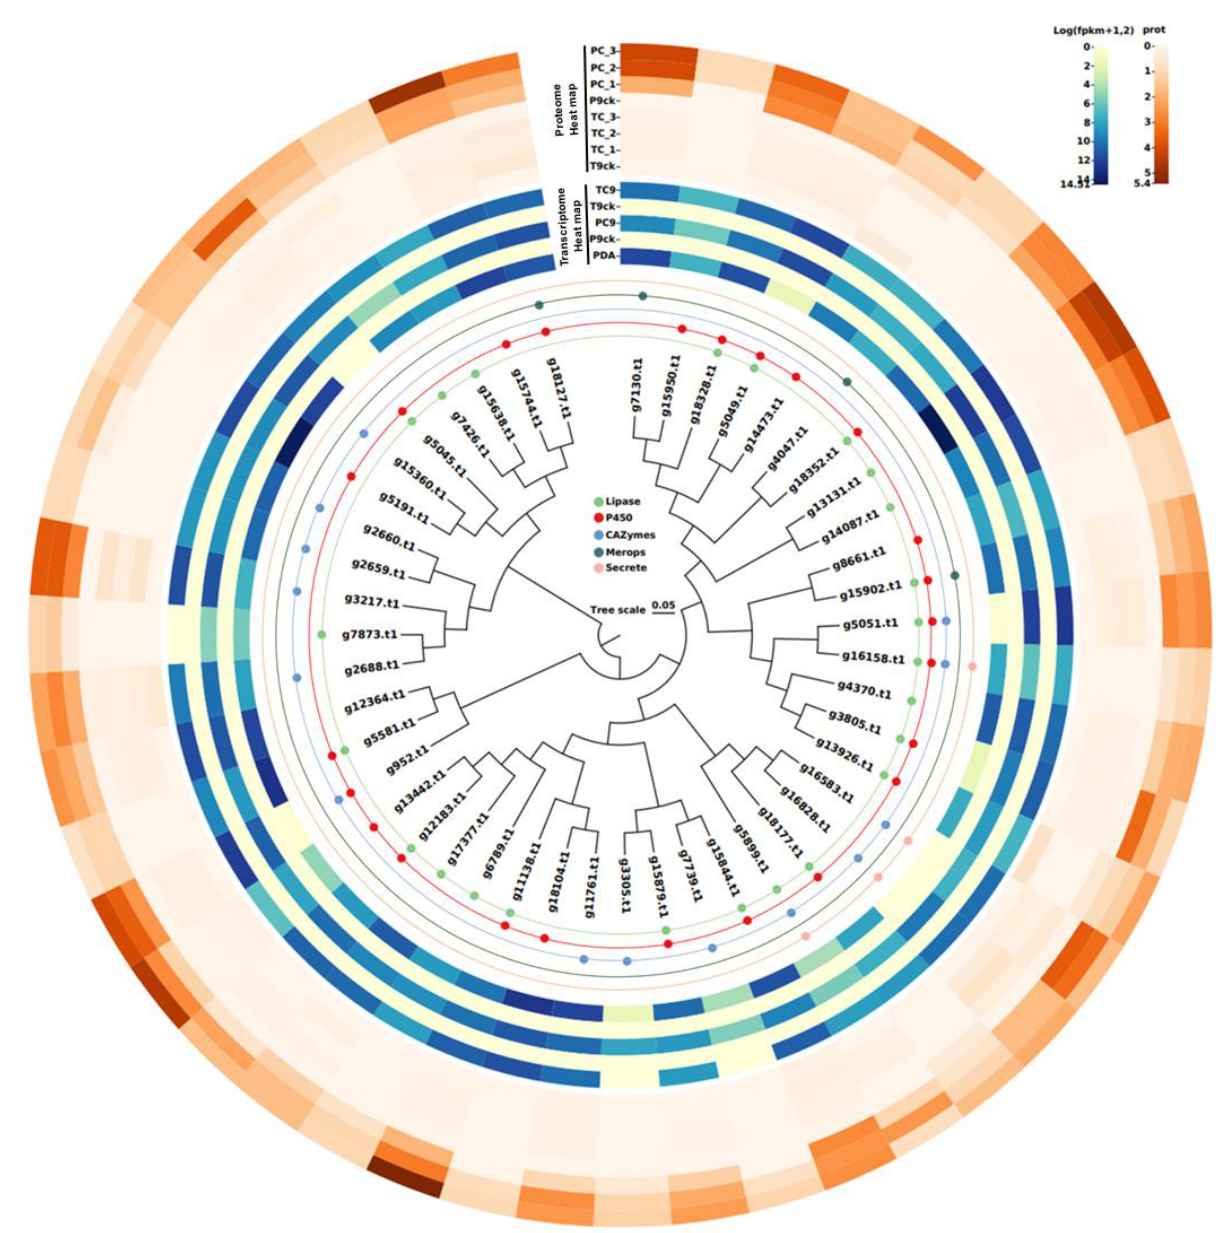
Figure 6. Annotation and expression of 46 putative virulence-associated genes. ML tree of 46 putative virulence-associated genes. The different colors of the round spots indicate the matching results with each database. Transcriptome level gene expression calorimetry. P9ck: P562 9 days after